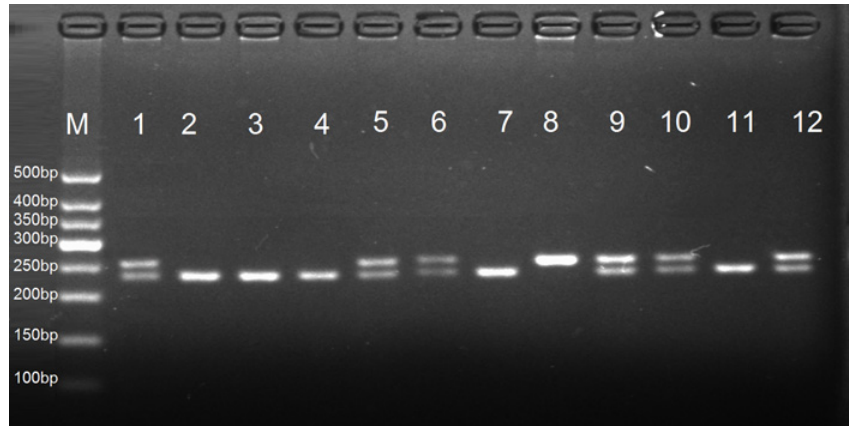
Figure 1. PCR-RFLP assay for analyzing the rs1800247 polymorphisms of the osteocalcin gene. Lanes M: DNA Marker; Lanes 1, 5, 6, 9, and 10 show Hh genotype; Lanes 2, 3, 4, 7, and 11 show hh genotype; lane 8 shows HH genotype.